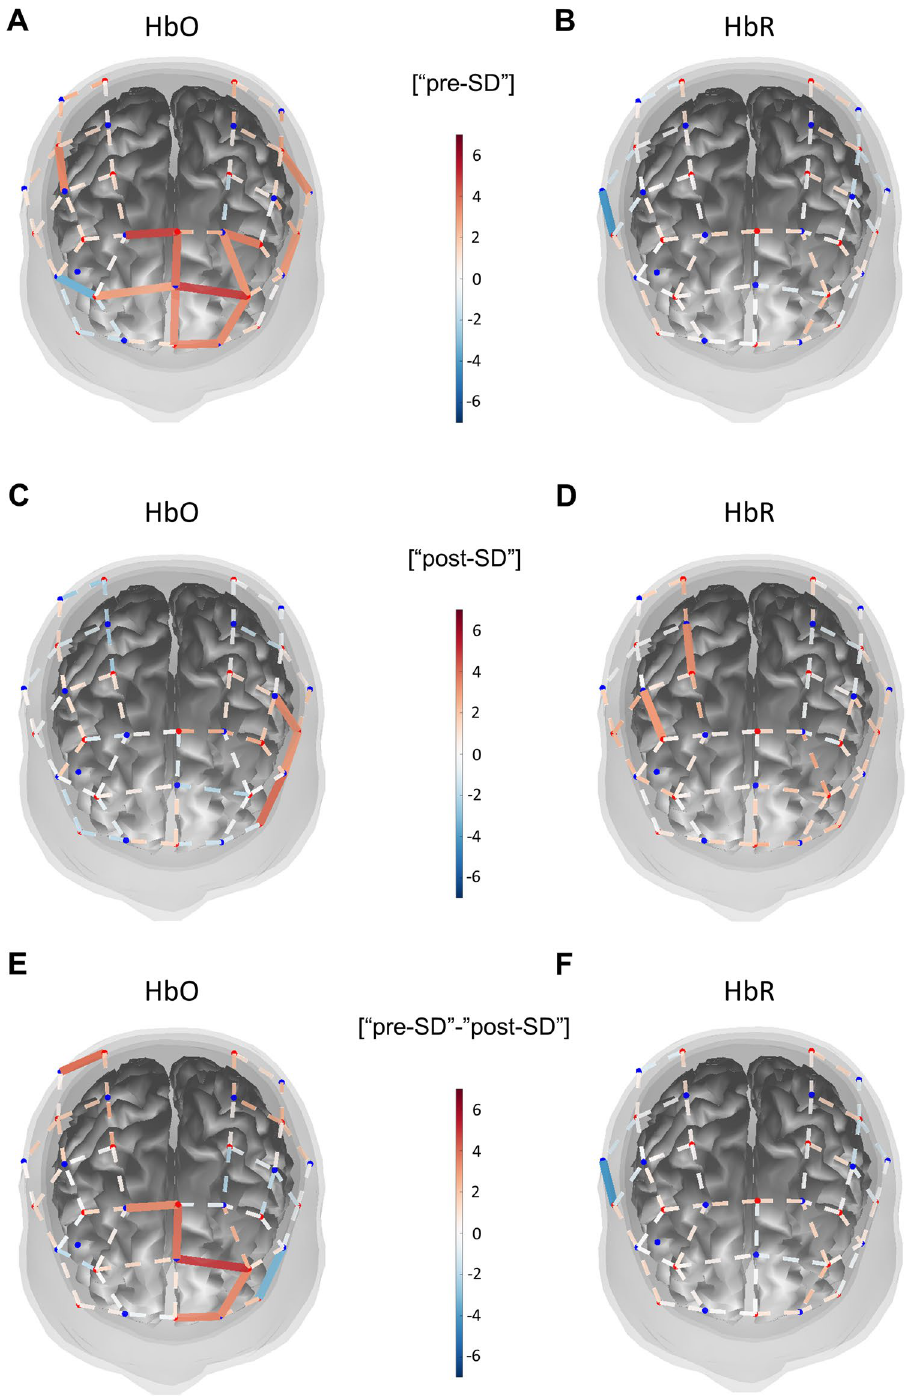
Figure 5. Sleep deprivation significantly impairs cortical hemodynamic responses measured using functional near-infrared spectroscopy. During functional near infrared spectroscopy (fNIRS) assessments, NVC-related hemodynamic responses were evoked by performing a finger tapping task initiated by auditory commands. Participants were seated in front of a desk, and an fNIRS cap covering areas of the prefrontal cortex and motor cortex was positioned on their head. A stimulation software instructed subjects with an auditory command to tap with the left or right index finger. Three 10 s trials were recorded for both hands. A General Linear Model based approach was used to extract beta weights estimating hemodynamic signal. Parameter estimates were used for further group-level statistics. Group level statistics were performed using mixed effect model statistics. Group average of responses are shown pre-SD (oxyhemoglobin, HbO: Panel A, deoxy-hemoglobin, HbR: Panel B) and post-SD (HbO: Panel C, HbR: Panel D). A t -contrast of [+ 1, −1], [pre-SD-post-SD] was applied on group level results. NVC responses were more pronounced: HbO was increased (Panel E) and HbR was decreased (Panel F) pre-SD when comparing it to signals recorded post-SD. The Brain AnalyzIR Toolbox 27 was used to generate result images. Results of the group level statistics are plotted as a 3D mesh over the Colin27 atlas 73 . Red and blue dots represent the optodes of the probe (red: light source, blue: detector). Solid lines connecting optode positions represent channels with statistical significance (FDR corrected p < 0.05), plotted values are t -values obtained through a t -test, warm colors representing t -values greater than 0, cold colors representing t -values lower than 0. Numerical results are shown in Supplemental Table